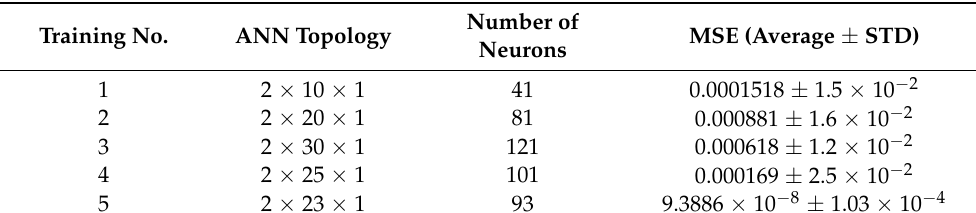
Table 5. Rudimentary statistical analysis of the optimal ANN.